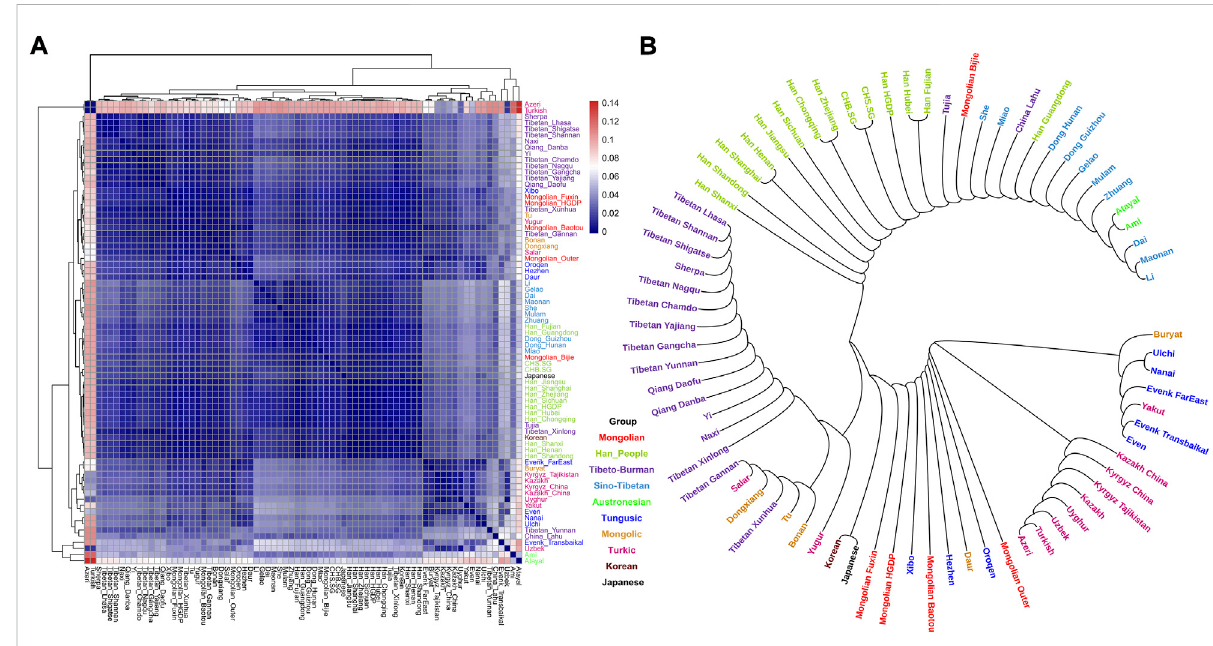
FIGURE 3 Results of pairwise FST among modern East Asian populations. Each population was marked by different colors which was corresponded to their language category. (A) Heatmap showed the pairwise FST genetic distance. (B) Neighbor-joining (NJ) phylogenetic tree showed the genetic relationship between Fuxin Mongolians and other modern East